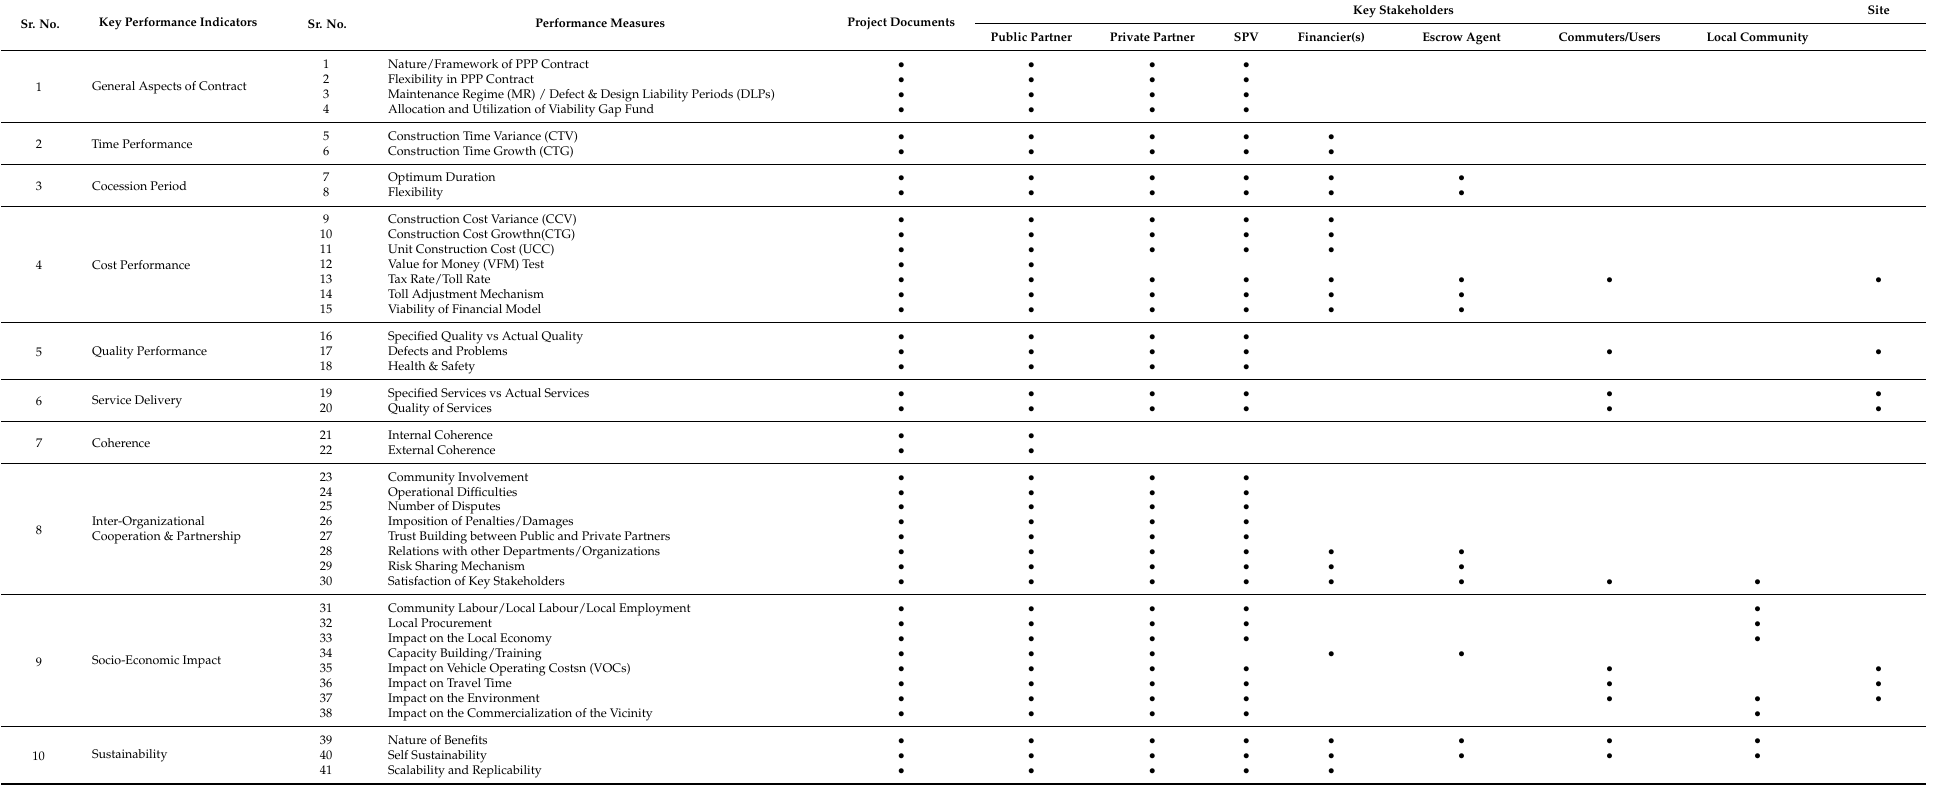
Table A1. Potential information sources for each performance